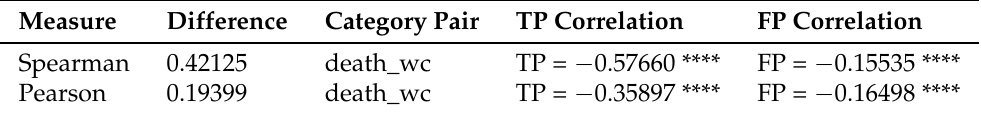
Table 23. Death and Word count in